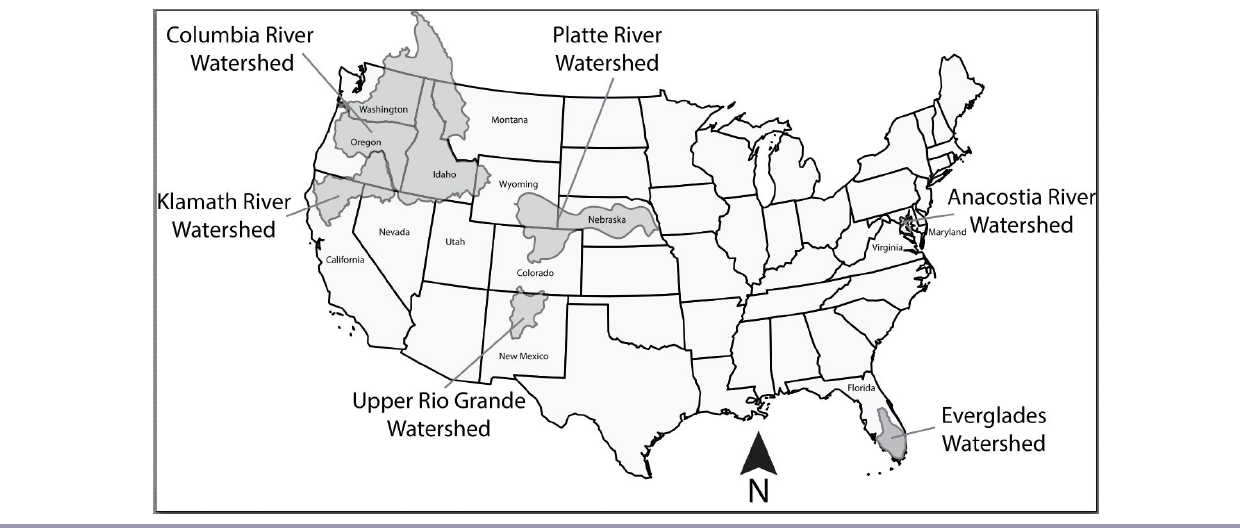
Fig. 1 . Location of regional scale, social-ecological water systems in the United